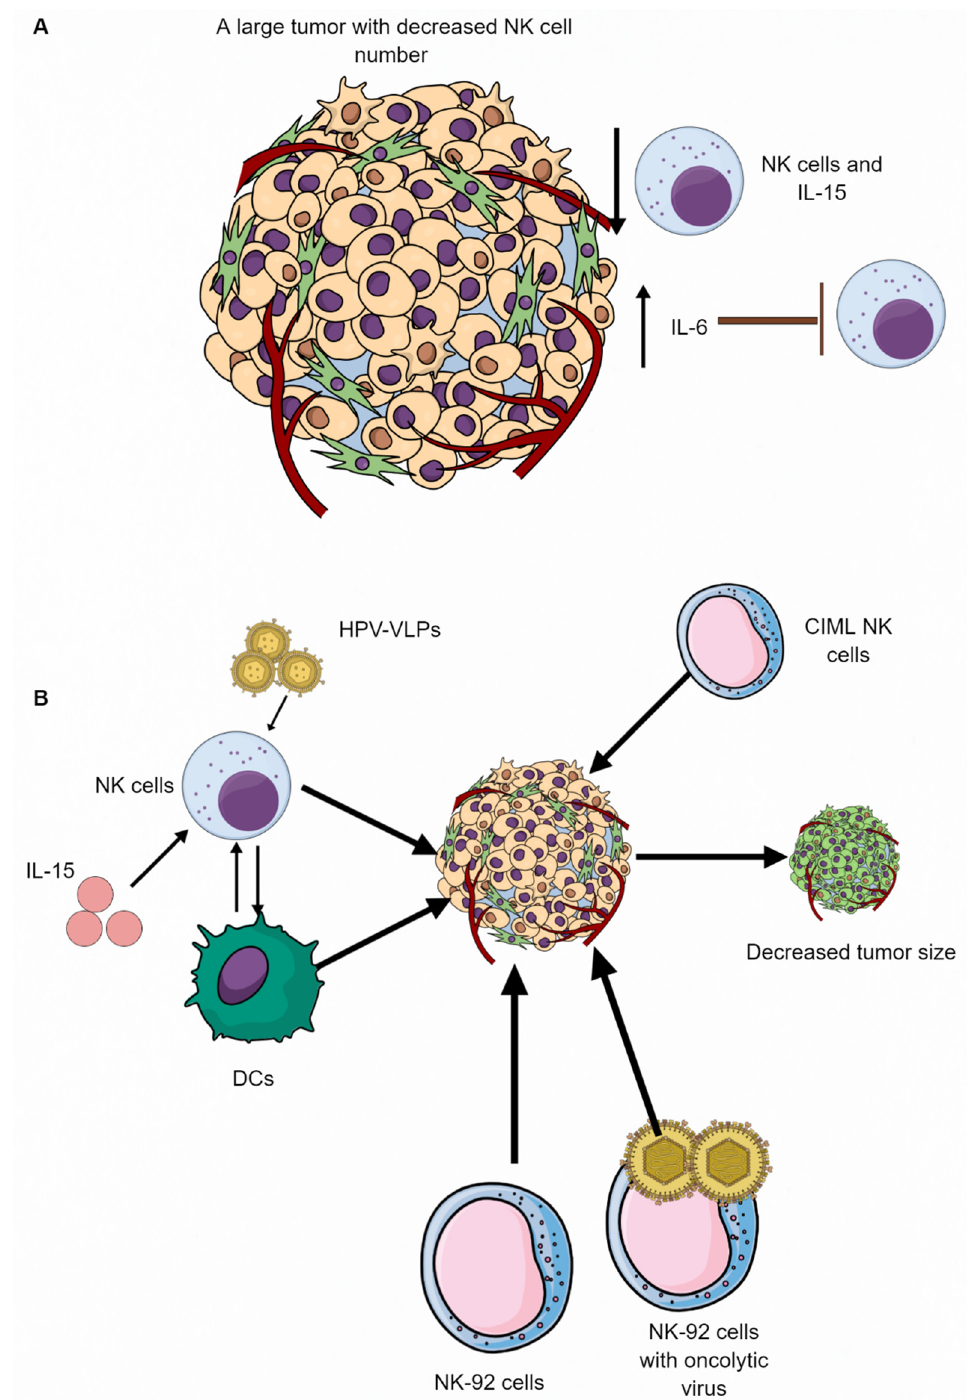
Figure 3. NK cell in TME or TIME and strategies to enhance their antitumor action. ( A ). Large tumors show a decreased NK cell number with dysregulated function due to the immunosuppres- sive TIME, including a decreased IL-15 level. Additionally, their TIME has elevated IL-6 level that suppresses NK cell function ( B ). Different strategies have been developed to enhance NK cell antitu- mor functions, including HPV virus like particles (VLPs), IL-15 treatment, NK-92 cells, NK-92 cells carrying oncolytic viruses, and CIML-NK cells. These therapies have potentially decreased the tumor size and burden in animal studies and in different clinical trials. Kindly see text for details.